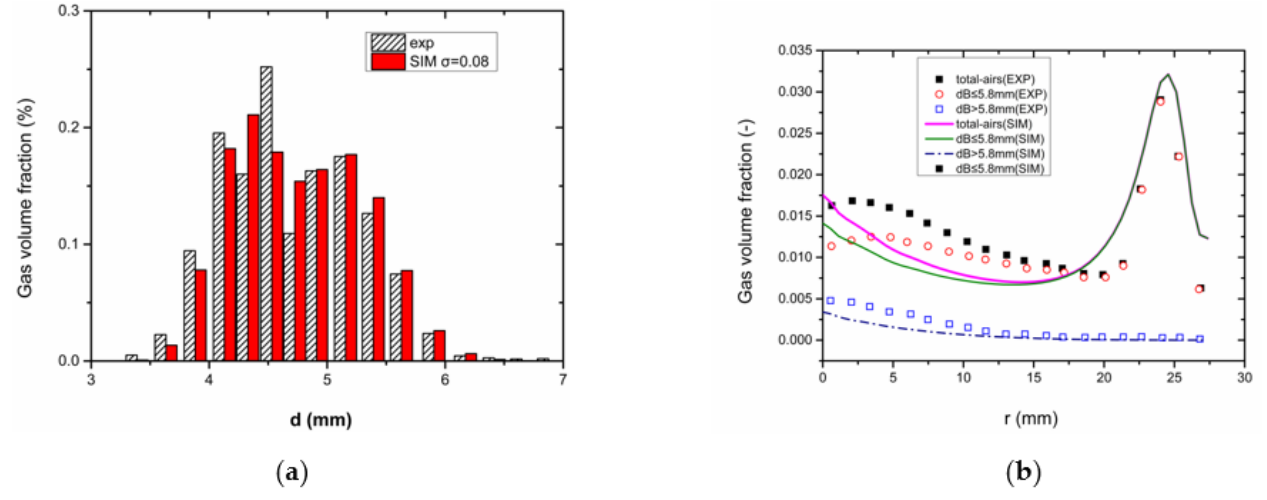
Figure 19. Calculation results of bimodal distribution by the multi-fluid model. ( a ) Histogram of bubble diameter distribution, ( b ) Distribution of gas volume fraction along the pipe